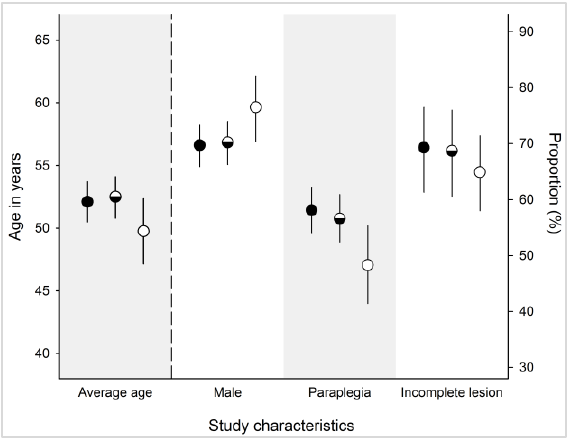
Figure 2: Population-average estimates with 95% confidence intervals of study characteristics. The axis on the left, age in years, corresponds only to the first category: average age. The axis on the right corresponds to the categories: male, paraplegia and incomplete lesion. Circles filled in completely indicate cases identified using criterion A. Half-filled circles in- dicate cases identified using criterion B. Open circles indicate cases identified in the SwiSCI